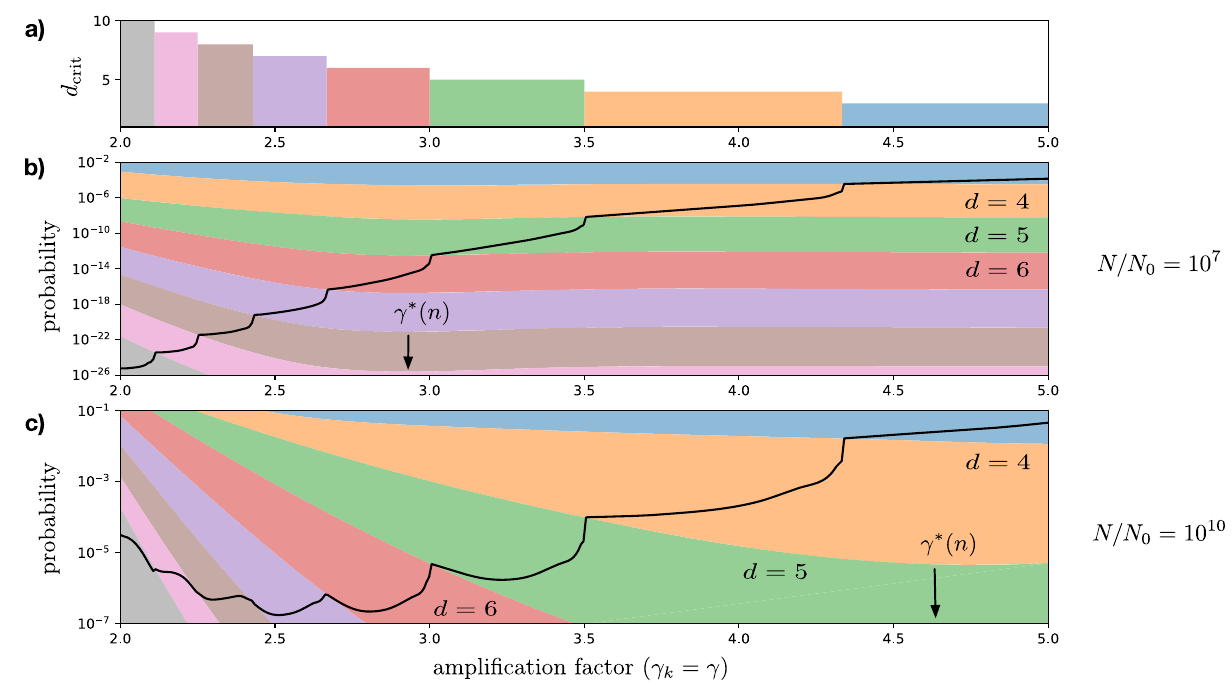
Fig. 2 Trade-off between mutation accumulation and proliferative disadvantage. a the number of driver mutations d ( s , γ ) necessary for carcinogenesis for s = 0.1 as a function of the uniform ampli fi cation factor γ k = γ . b , c Two hierarchies with cells organized into n + 1 hierarchical levels, and differing only in the number of terminally differentiated cells produced per stem cell during the lifetime of the tissue, respectively, N / N 0 = 10 7 and N / N 0 = 10 10 , are shown. The probability of accumulating a suf fi cient number of mutations for carcinogenesis to occur, P cancer ð s ; μ ; H ; t life Þ is shown with a thick black line for each. In addition, for both, the range of probabilities for accumulating d = 3,4, … mutations out of d crit ( s ) critical mutations are shown with colored bands together with the ampli fi cation factor that minimizes divisional load γ k ¼ γ (cid:4) ð n Þ ¼ ð N = N 0 Þ 1 = n . The top of each band corresponds to the probability of accumulating d − 1 mutations with strength s , while the bottom of each corresponds to accumulating d mutations, cf. Eq. (11). In both plots N 0 = 1, n = 15, s = 0.1 and μ = 10 − 6 .